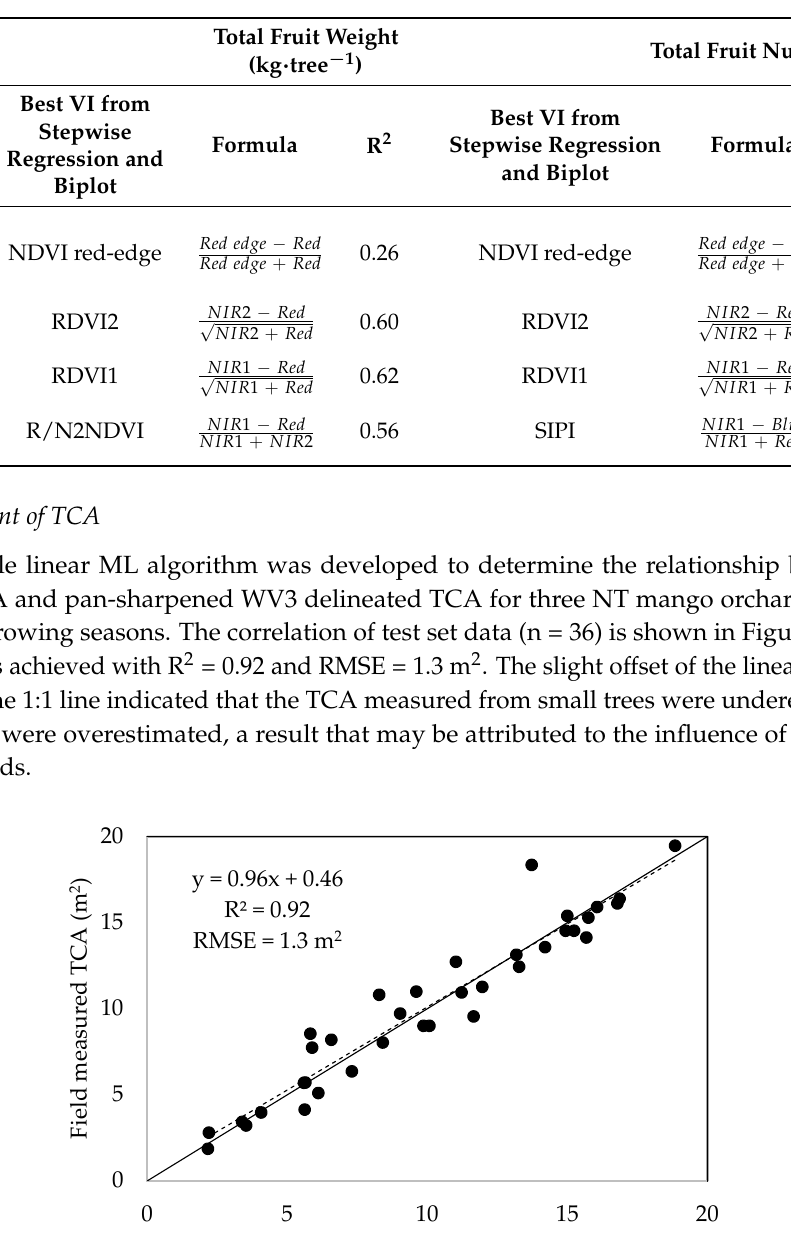
Table 1. Best vegetation indices (VIs) for all orchards and for each orchard separately for total fruit weight (kg · tree − 1 ) and fruit number using multivariate stepwise regression and biplot.